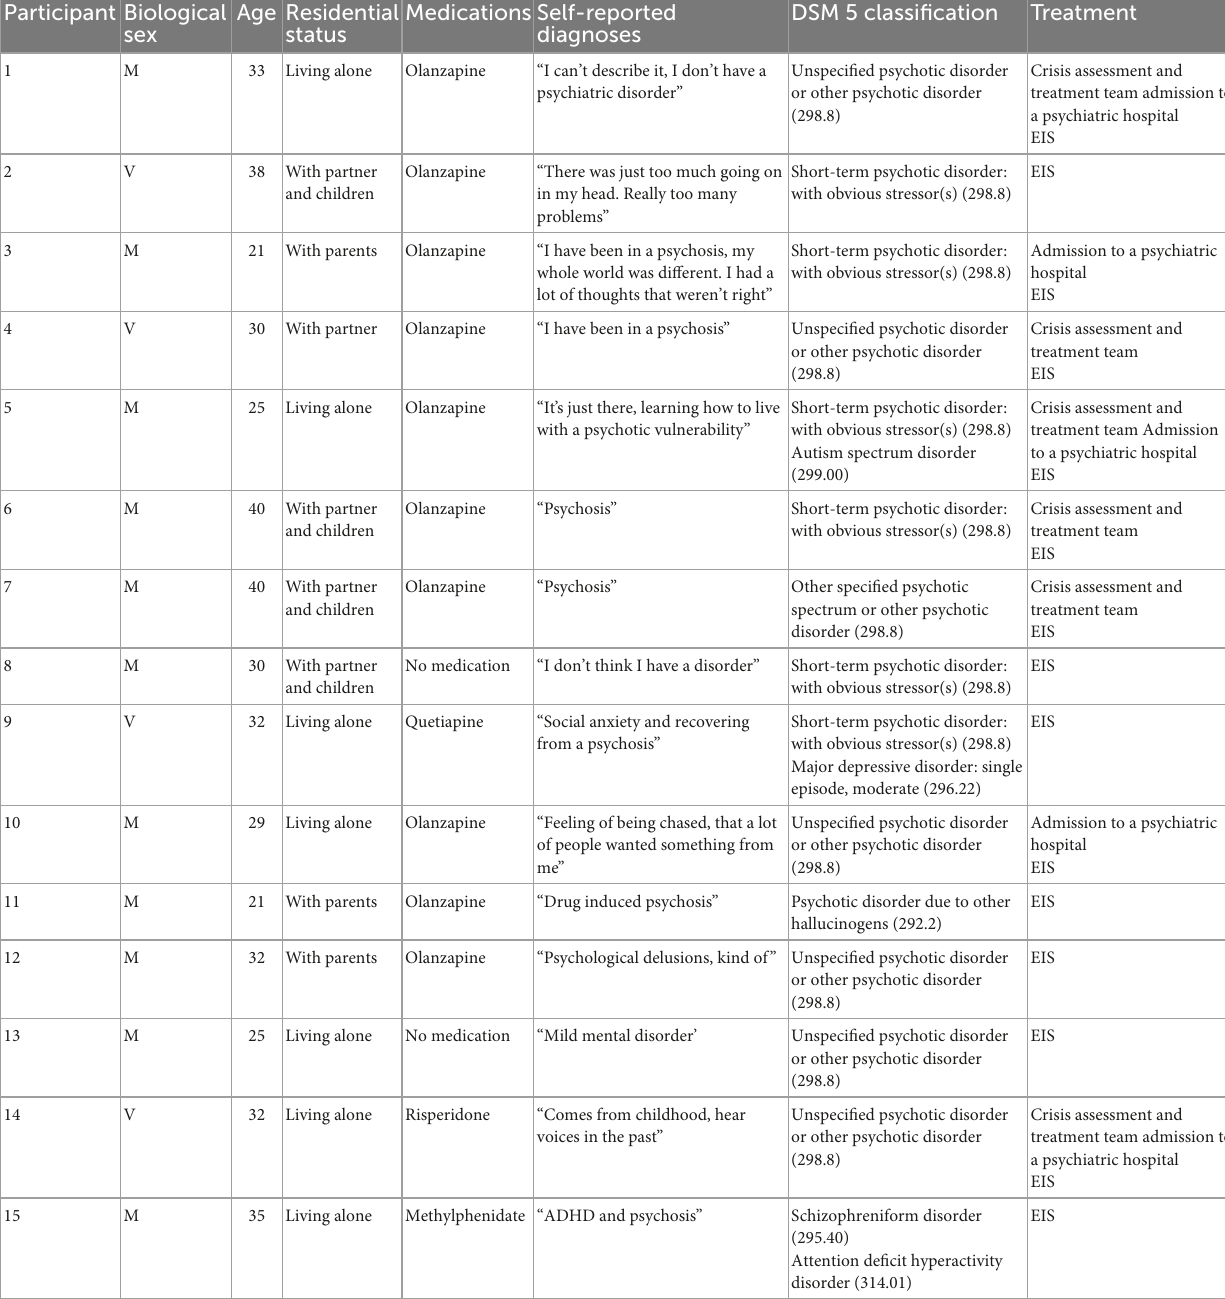
TABLE 1 Participant demographics, medications, self-reported diagnoses and DSM 5 classification ( N = 15). Participant Biological